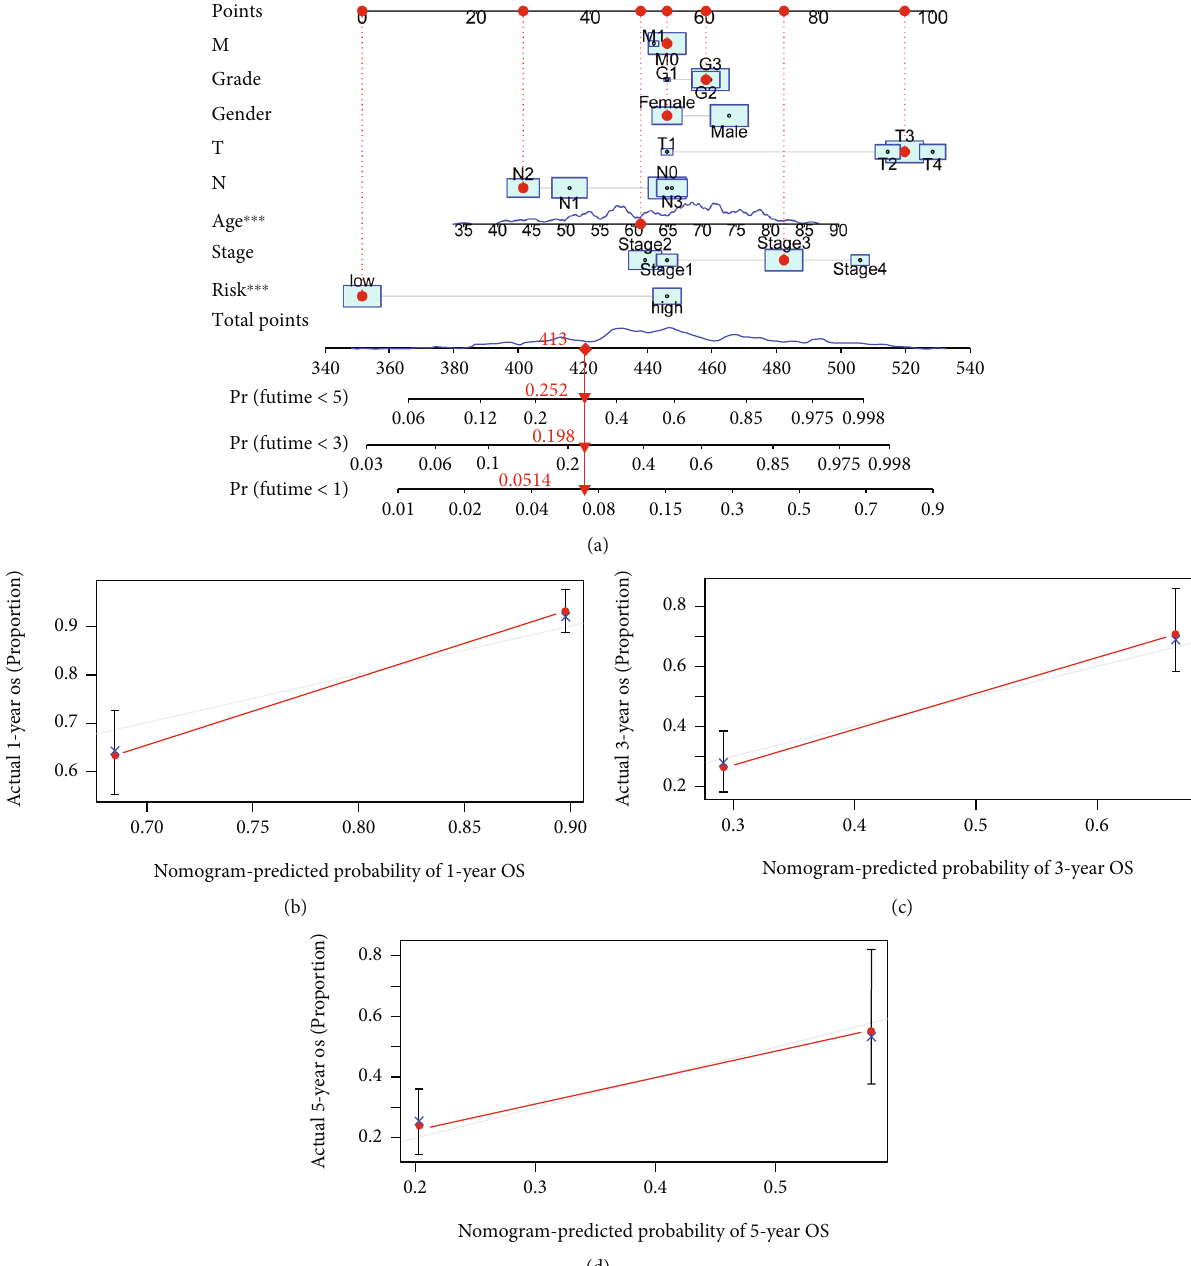
Figure 8: Accuracy validation in prognosis of the risk model. Nomogram was plotted for predicting survival time of patients (a). The accuracy in prognosis of the risk model was determined with calibration curves ((b) –